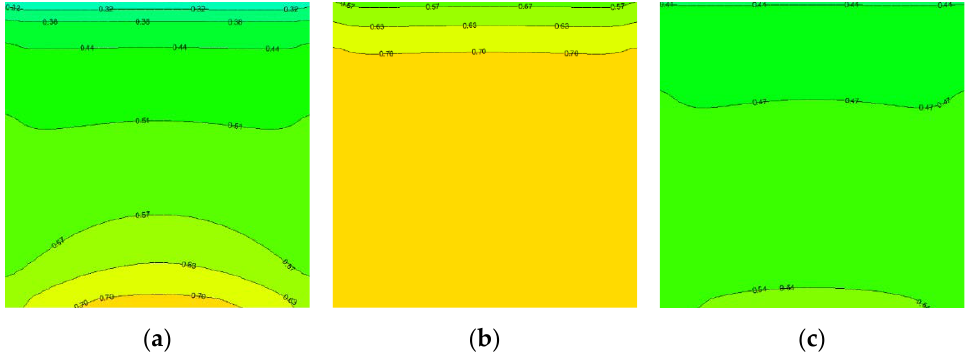
Figure 9. Remaining oil distribution of each layer after water flooding stage of Figure 1: ( a ) low- permeability layer, ( b ) medium-permeability layer, ( c ) high-permeability layer.